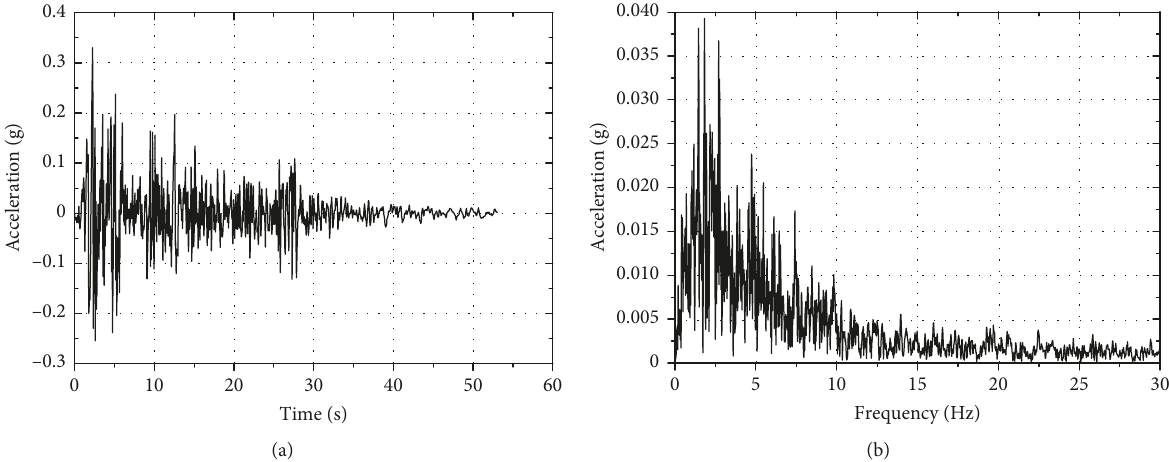
Figure 7: Acceleration time history and Fourier spectrum of El Centro earthquake wave. Table 3: Test